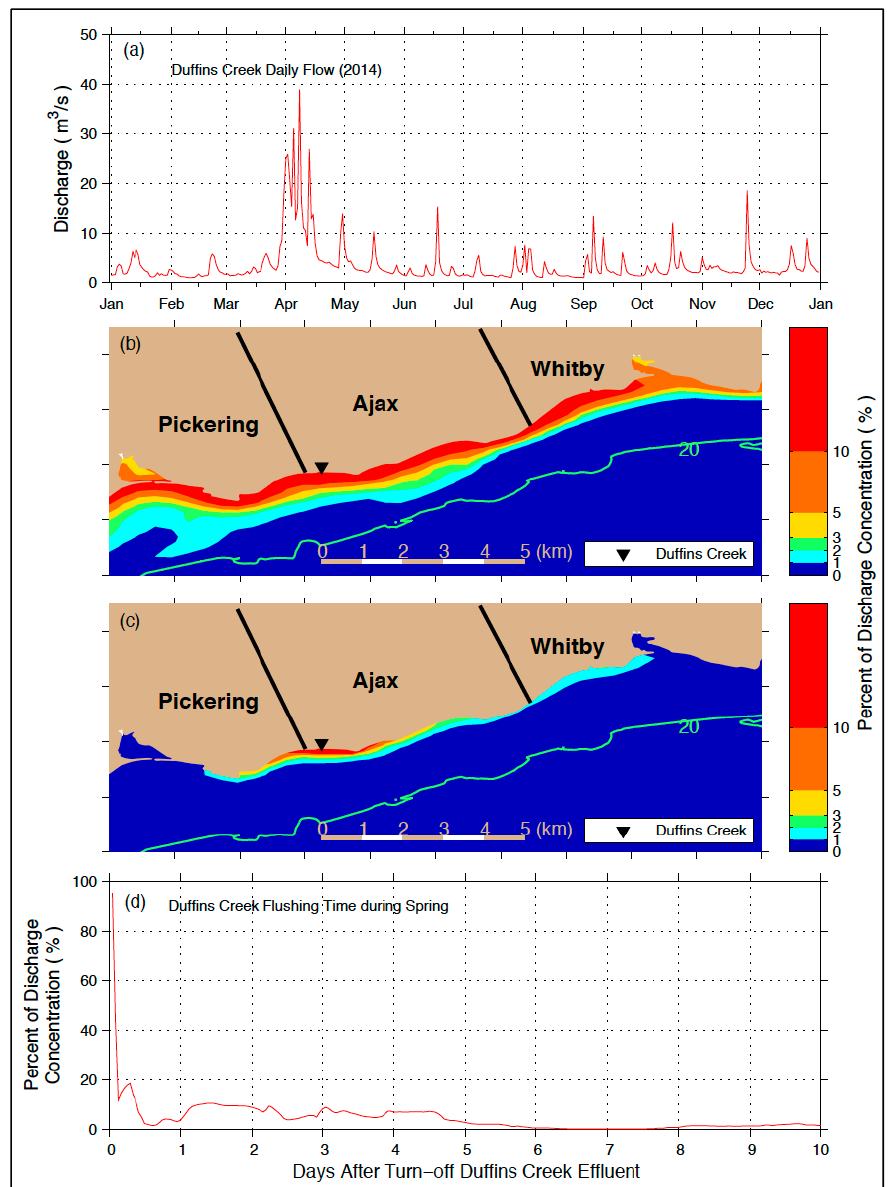
Figure 10. Model inputs and results for tributary simulations: ( a ) Duffin Creek flows for 2014, ( b ) Duffin Creek plume for high-flow conditions, 4–10 April 2014 (model results are from run#3), ( c ) Duffin Creek plume for low-flow conditions, 13–19 July 2014 (model results are from run#4), and ( d ) purging of the Duffins Creek plume from nearshore waters (model results are from run#5).